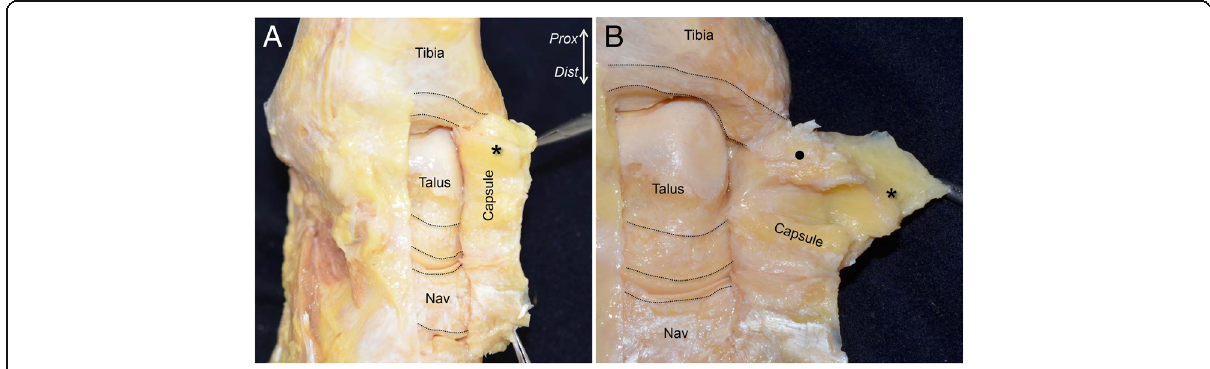
Fig. 2 Attachments and inner appearance of the anterior capsule of the anteromedial ankle. a To expose the attachment of the joint capsule, we detached it from lateral to posteromedial. The superior aspect of the ankle joint is shown. The black dotted lines indicate the dimension of the capsular attachments. The anterior part of the joint capsule consisted of fatty tissue (asterisk). b The capsule was detached medially. The anterior fatty tissue of the capsule changed to fibrous tissue (black circle) at the anteromedial aspect of the ankle joint. Prox, proximal; Dist, distal; Nav ,